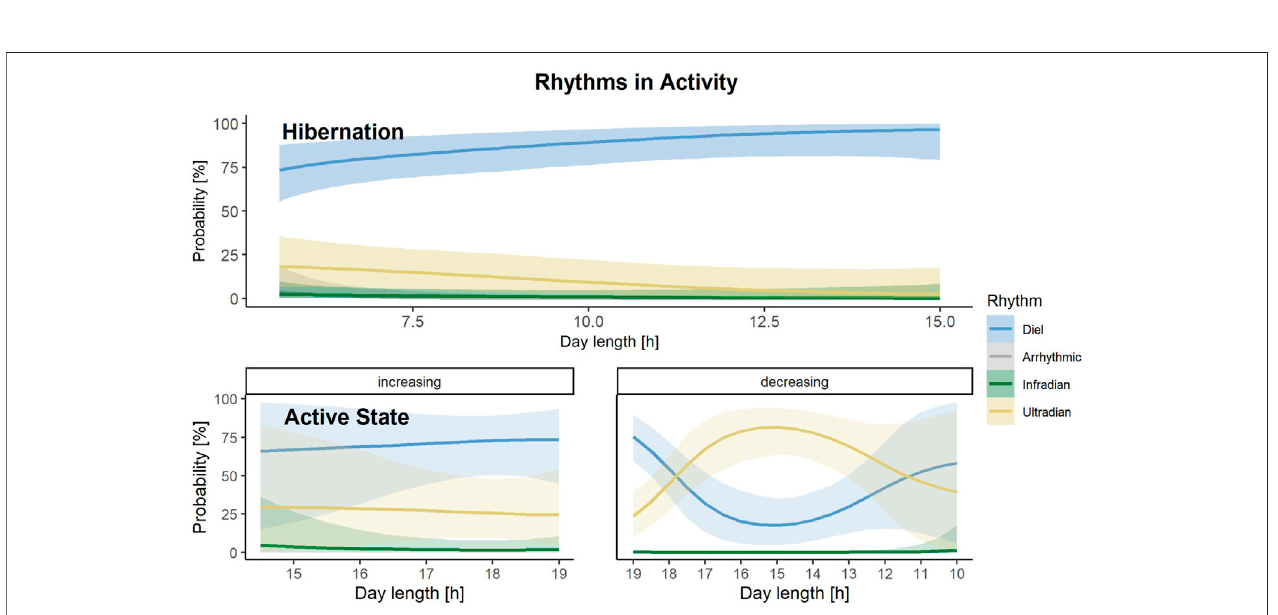
FIGURE6| Predictionoftheprobabilitythateitheradiel(blue),infradian(green),ultradian(yellow)orarrhythmic(grey)rhythminactivityisdisplayedbyScandinavian brown bears during the active or hibernation state, depending on increasing or decreasing day lengths [h] during active state and increasing day length [h] during hibernation in the study area in south-central Sweden. Shaded areas indicate 95% credible intervals.